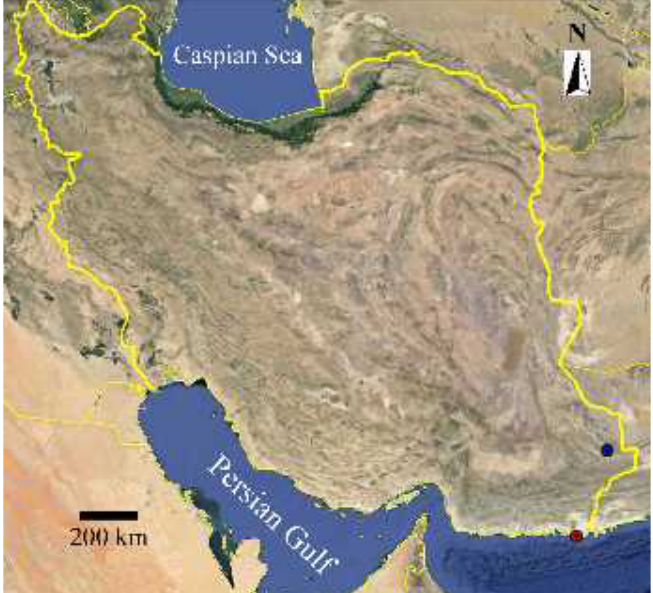
F IGURE 1. Map of Iran shows the new locality records for Ophiomorus brevipes (blue circle) and O. tridactylus (red circle) in Sistan and Baluchestan Province. Source of map from the Google earth